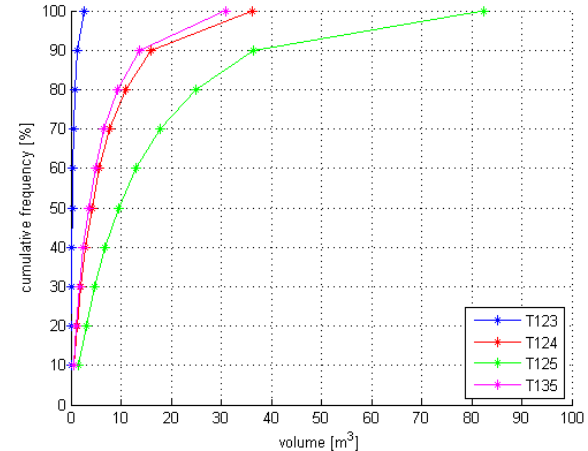
Figure 8. In situ block size distribution (IBSD) calculated according to Equation (2).